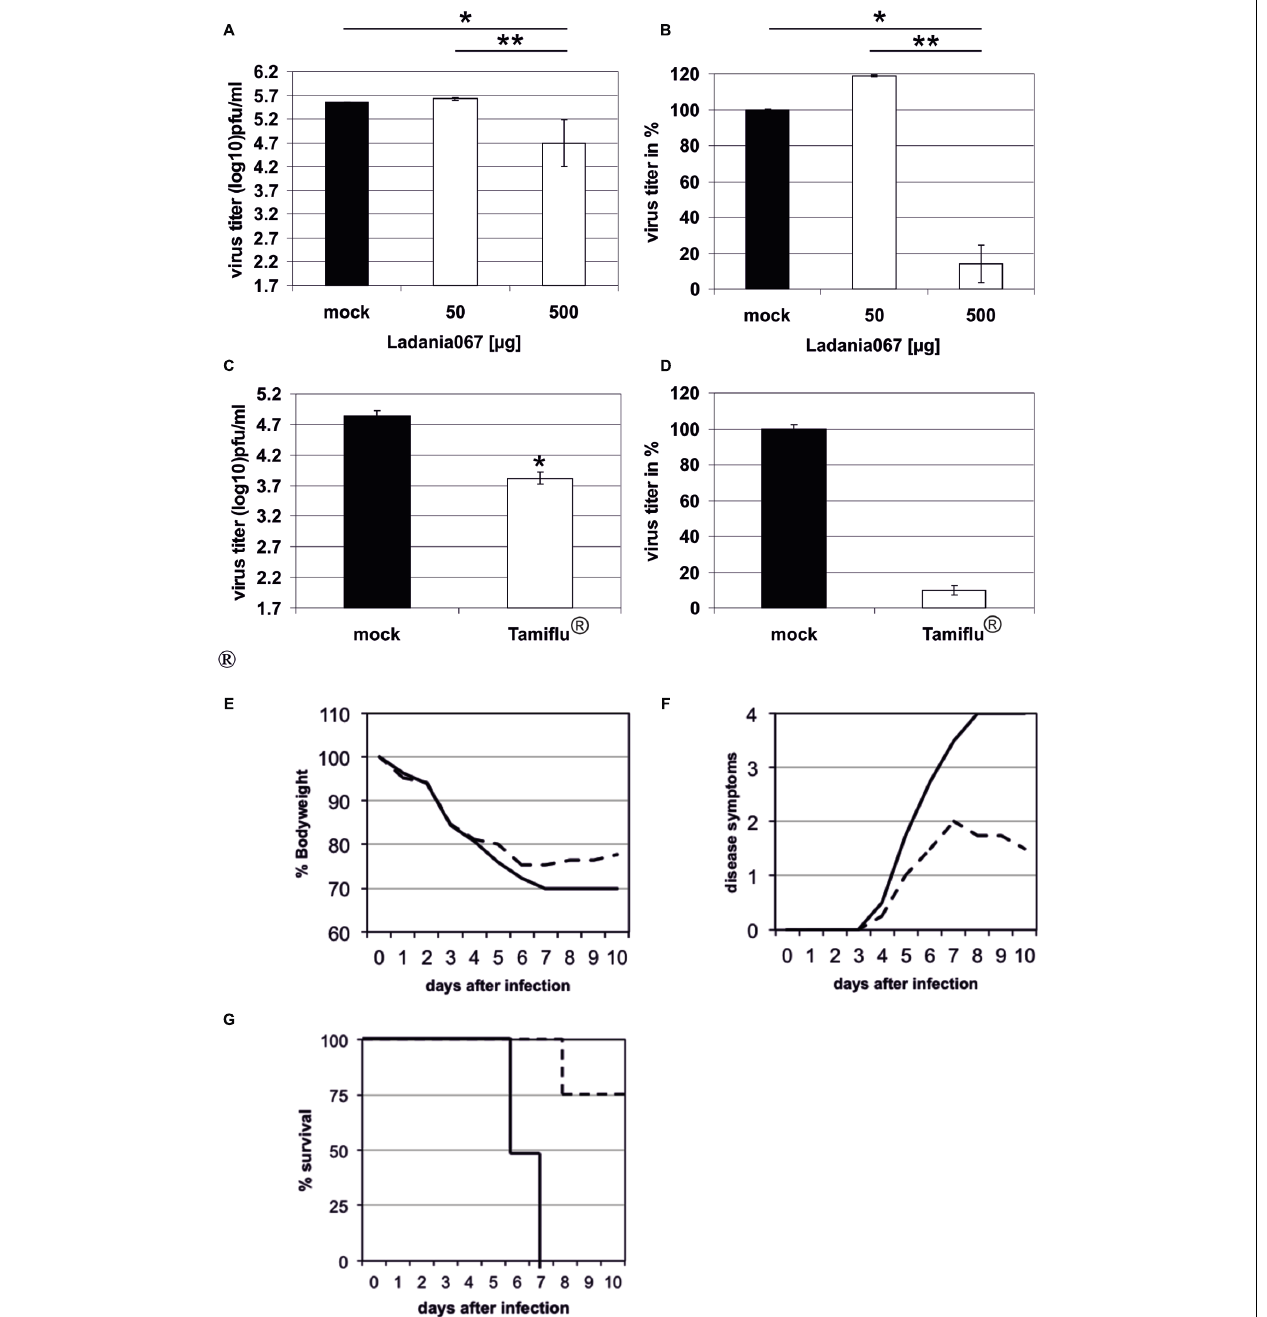
FIGURE 5 | Ladania067 administration reduces progeny virus titer in the lungs of infected mice. C57BL/6 mice were treated 30 min prior to infection via the intranasal route with either 50 μ g (four mice) or 500 μ g (five mice) Ladania067 in 50 μ l PBS. The control group (three mice) received 50 μ l of the solvent (PBS). Within the anesthesia, mice were infected intranasally with the 5-fold MLD 50 of RB1. Lungs were collected 24 h after infection and viral titers were determined by plaque assay ( A : in pfu/ml, B : in %). Four C57BL/6 mice per group were treated 12 h prior to infection per os with 5 mg/kg Tamiflu ® in 200 μ l water. The control group received 200 μ l of the solvent (water). Immediately before infection with the 5-fold MLD 50 of RB1,